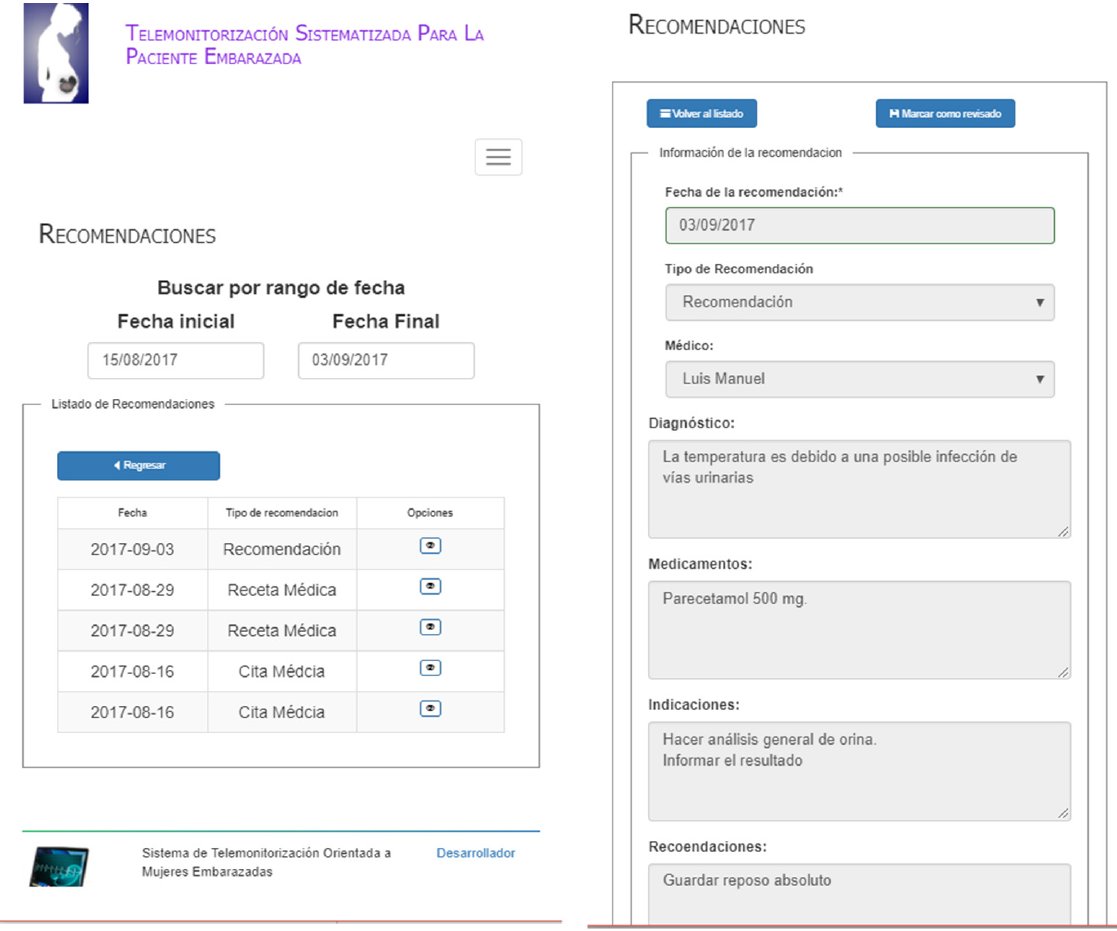
Figure 9. List and access to recommendations.